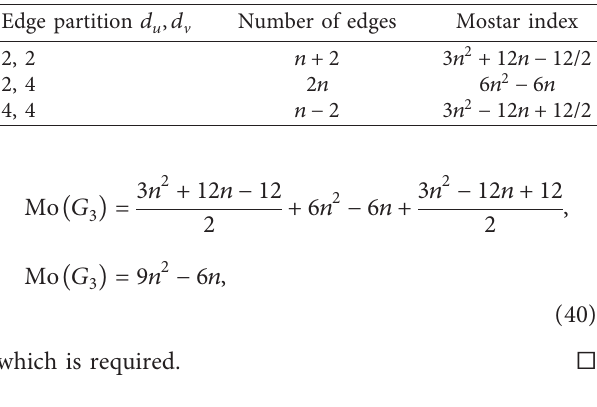
Table 17: Edge partition of ortho chain of even